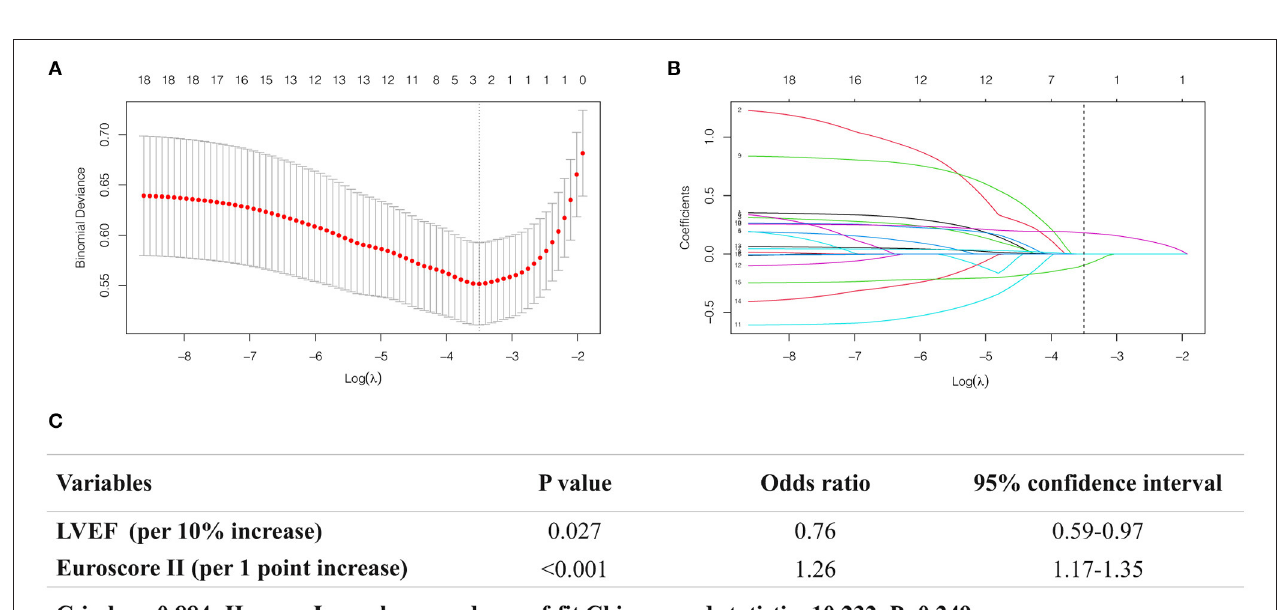
FIGURE 2 | Analysis of the factors associated with physicians’ decisions against intervention using LASSO-penalized logistic regression model. (A) The plot showing the deviance values of the LASSO model as a function of the tuning parameter λ . The optimal λ is the value that minimizes the deviance curve (dashed line). (B) Trace plot showing non-zero model coefficients as a function of the tuning parameter λ . As the λ increases, LASSO sets various coefficients to zero, thus removing them from the model. When λ corresponds to the minimum-deviance (dashed line), two variables are selected (C) .